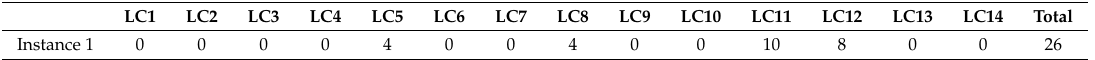
Table 2. Constraint violation distribution for Instance 1 using